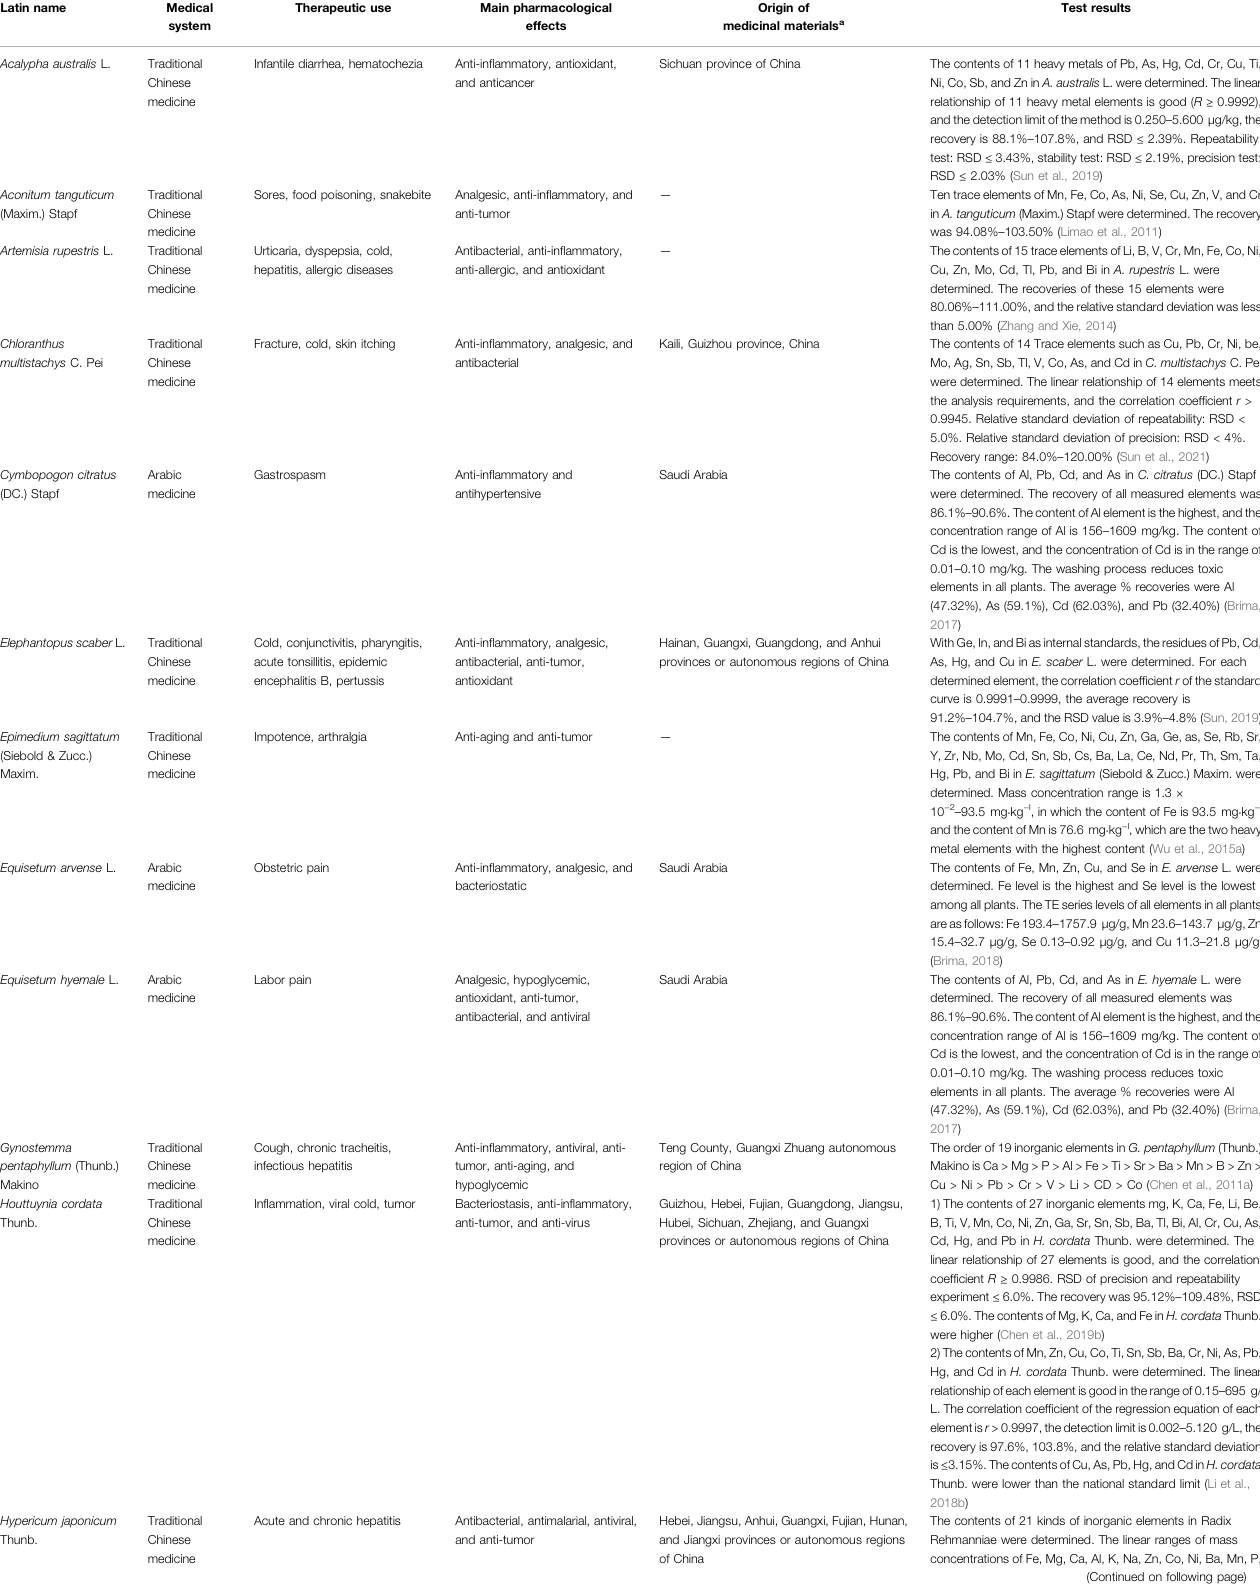
TABLE 6 | Application of ICP-MS in the determination of heavy metal elements in medicinal materials from the whole